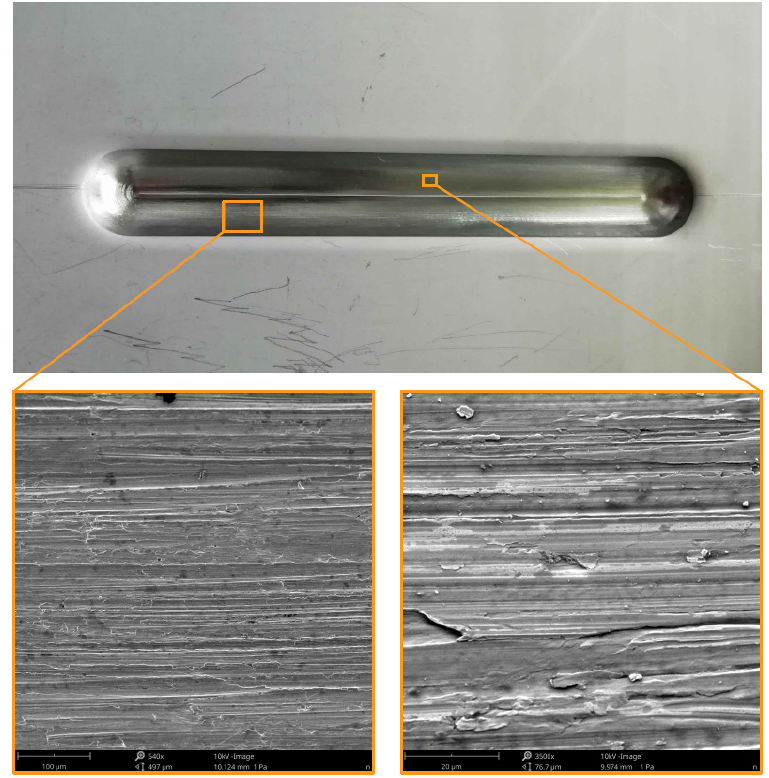
Figure 11. Macroscopic view and SEM images of the inner surface of the stiffening rib.